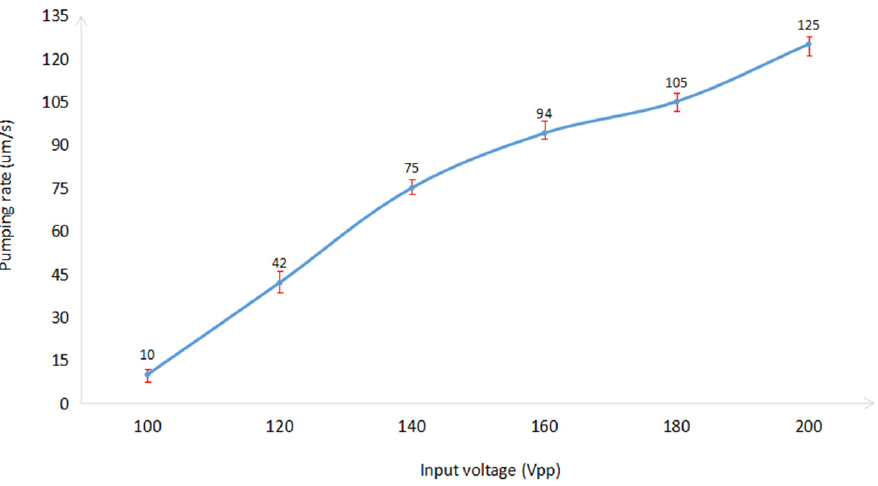
Figure 10. Pumping flow rates with various voltages applied to the piezoelectric transducer activated at 20.0 kHz.